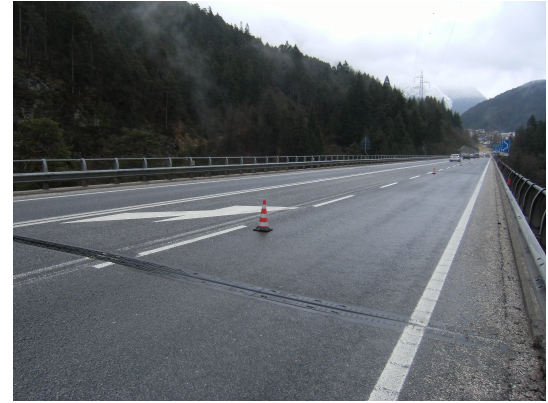
Figure 8: Top: original image. Bottom: example of segmentation